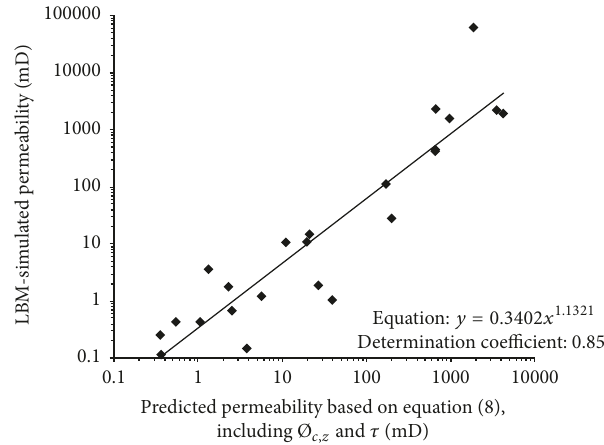
Figure 19: Predicted versus simulated permeabilities. The predicted permeabilities are based on an average between the permeability calculated from tortuosity and connected porosity for each